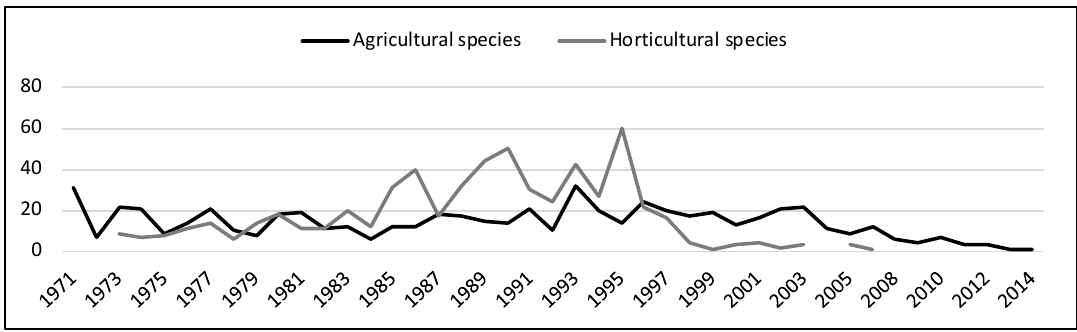
Fig. 3. Annual Plant Variety Protection Grants (PBRs)